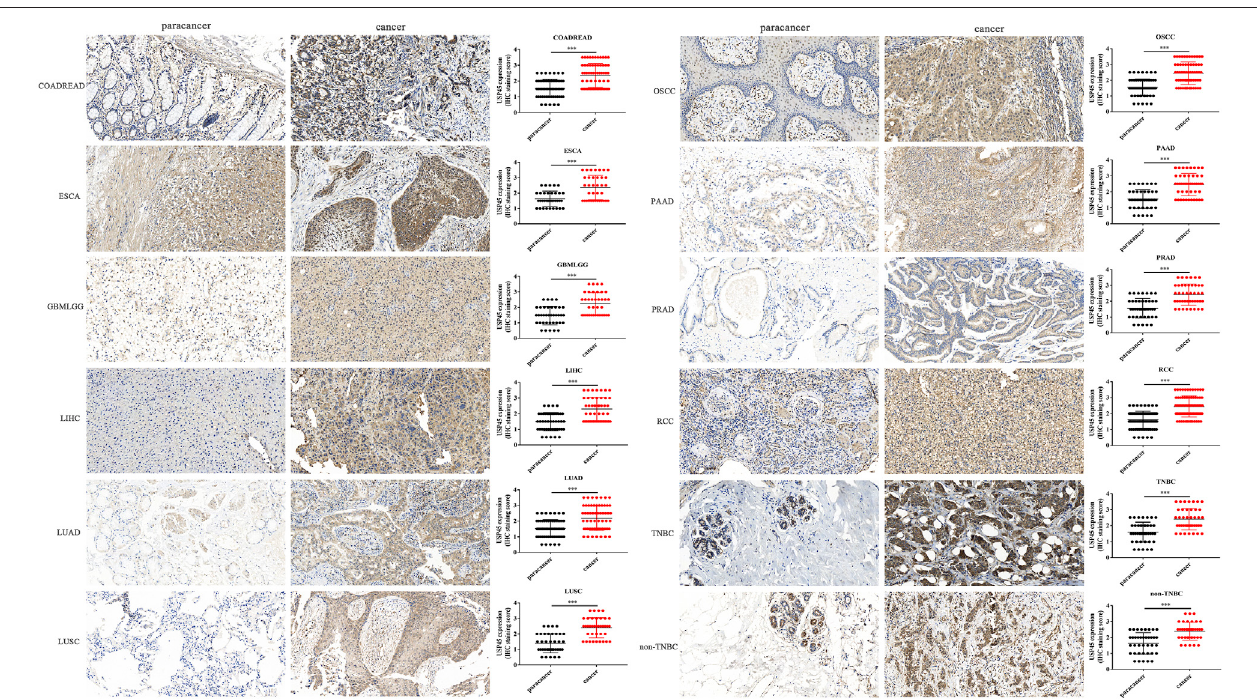
FIGURE10| TheproteinexpressionlevelsofUSP45in12typesoftumorsandpairedparacanceroustissues.TheproteinexpressionlevelofUSP45wasdetected and quanti fi ed by immunohistochemistry in COADREAD, ESCA, GBMLGG, LIHC, LUAD, LUSC, OSCC, PAAD, PRAD, RCC, TNBC, non-TNBC and their paired paracancerous tissues. *** p <